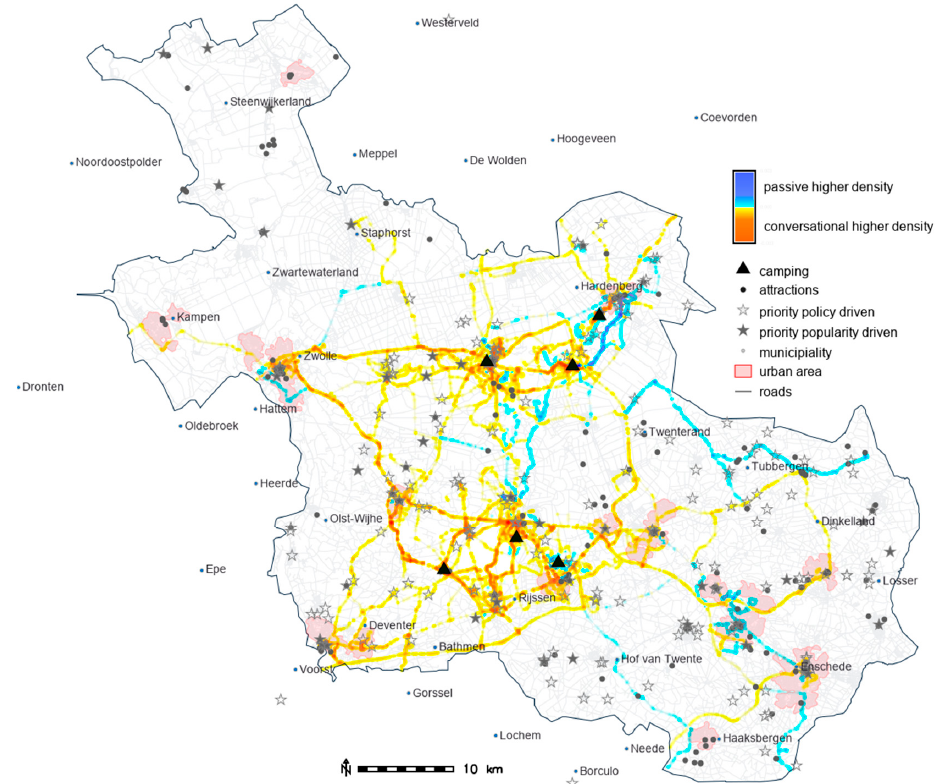
Figure 9. Difference between passive and conversational policy-driven participants.